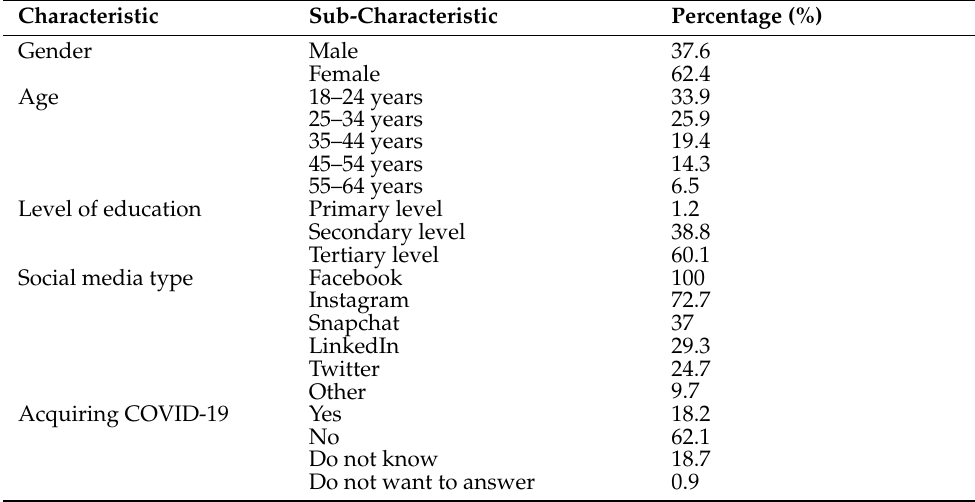
Table 1. Demographic characteristics of the